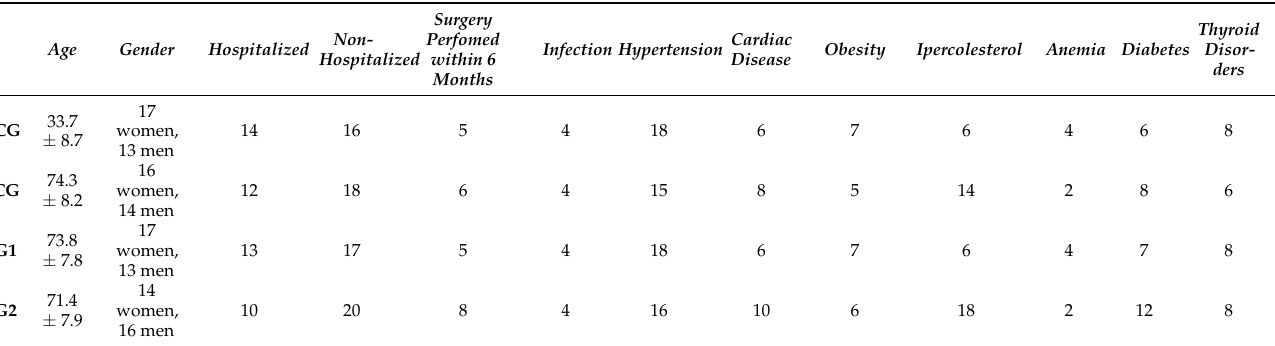
Table 1. Demographic characteristics of groups.